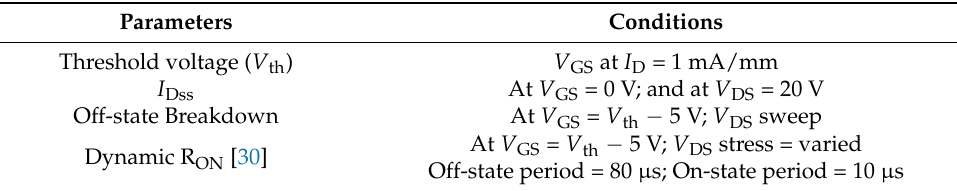
Table 2. Measurement parameters and